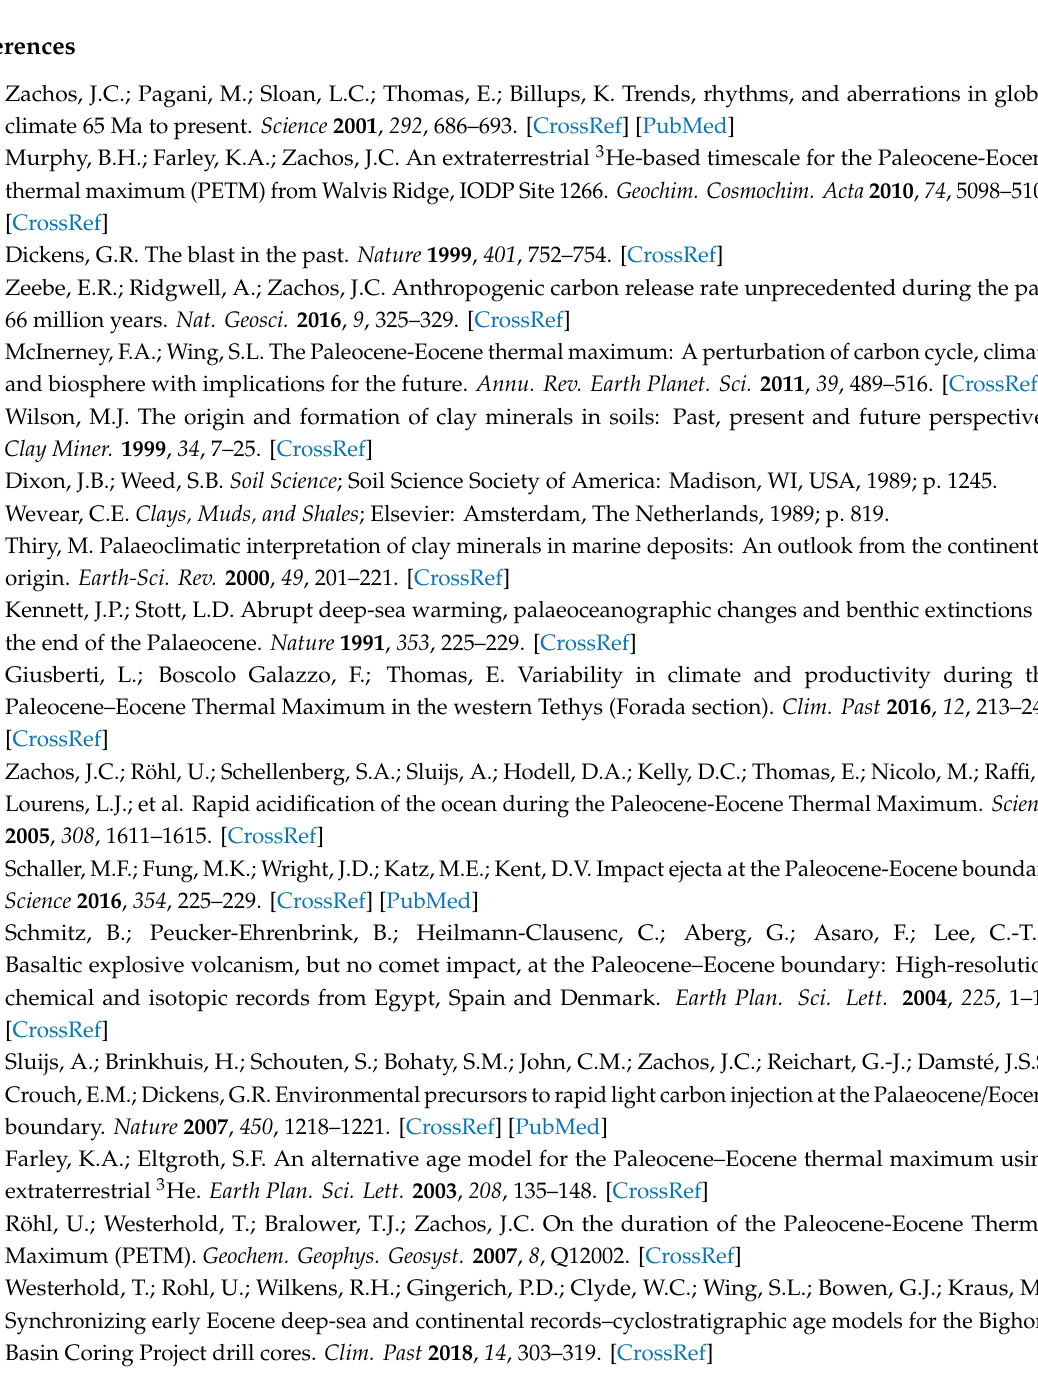
Table S1: Papers dealing with clay minerals at the PETM interval, following chronological order. The main features of the studied sites, methods, mineralogical results and data interpretations are reported. Abbreviations: Chl = chlorite, CIA = Chemical Index of Alteration; D = domain (c = continental, m = marine); Ilt = illite, m / c = marine (m) or continental (c) materials; ML = mixed layers illite-smectite, Kln = kaolinite, Plg = palygorskite, R = reference; Sep = sepiolite, Sme = smectite, XRD = X-ray di ff